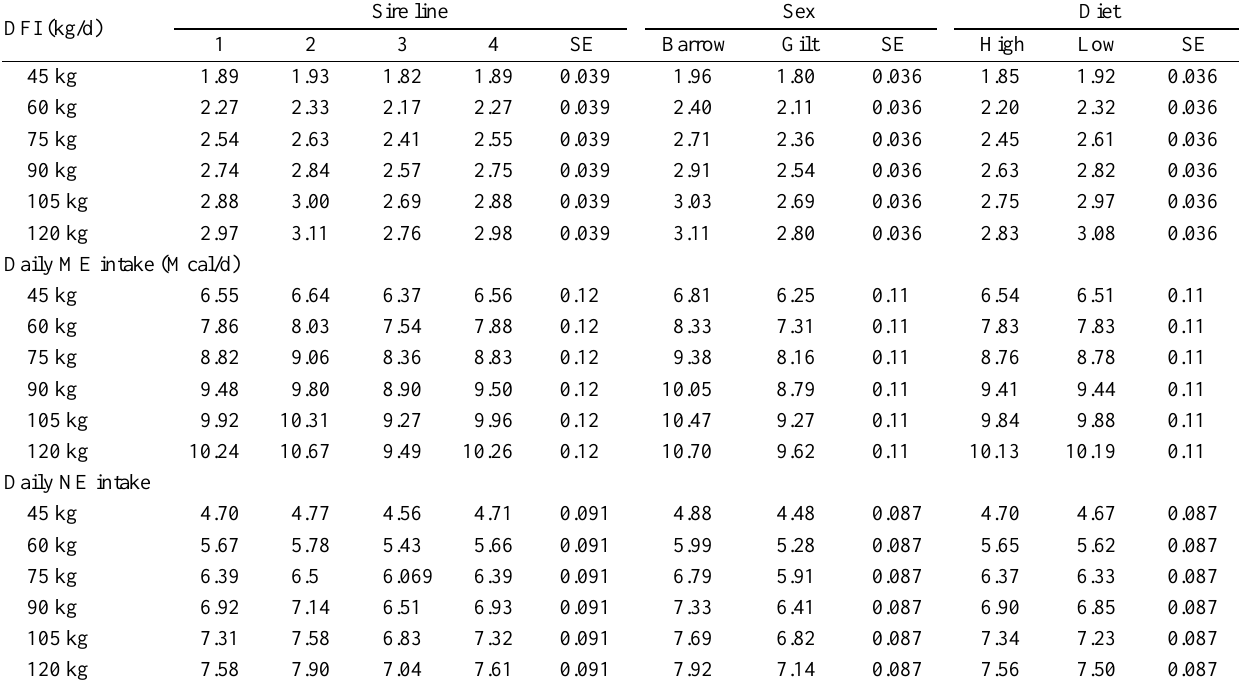
Table 10. Least-squares means for predicted daily feed intake, ME and NE intake at six BWs a DFI (kg/d)